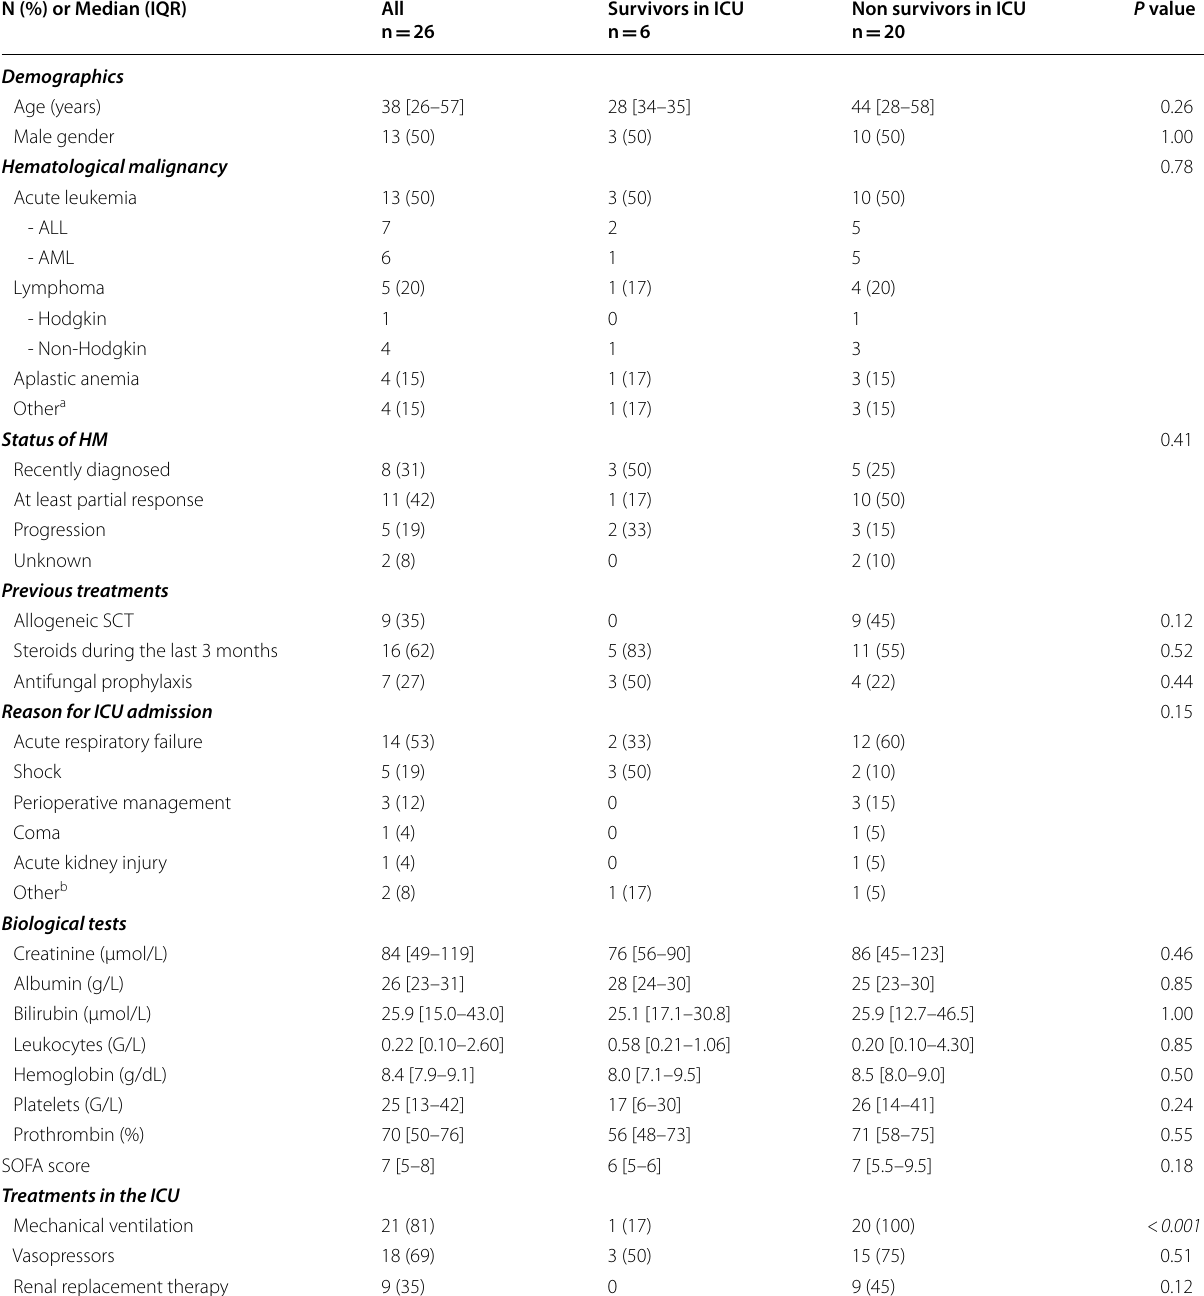
Table 1 Characteristics of patients at ICU